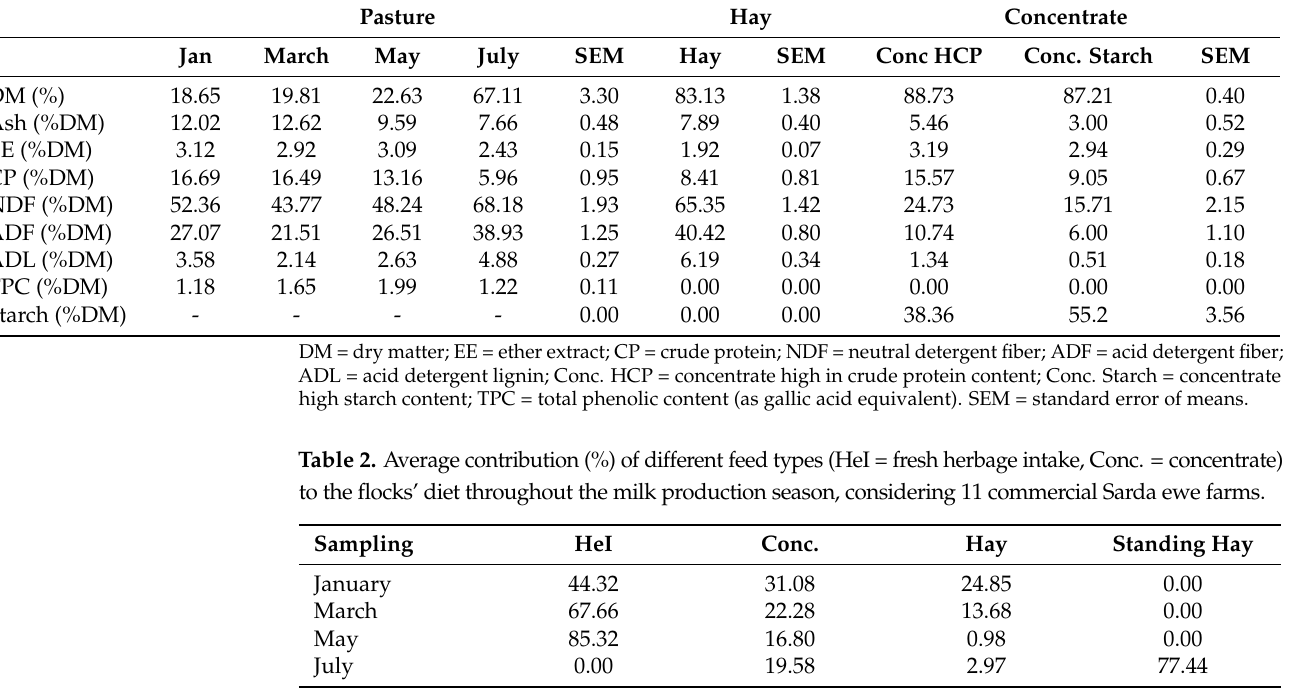
Table 1. Chemical composition of pastures and supplements used by farmers in the 4 sampling days. Pasture Hay